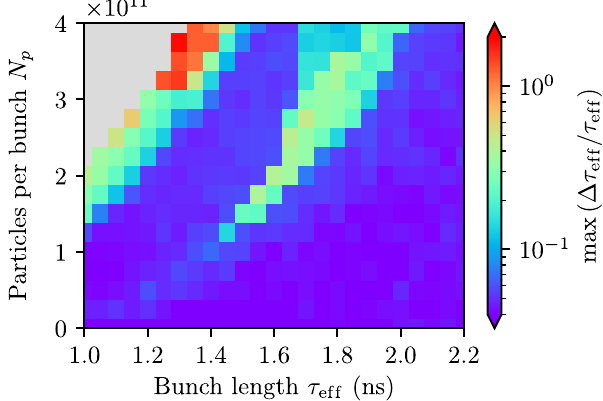
FIG. 2. Longitudinal stability map obtained from BL on D simulations for single-rf operation ( r ¼ 0 ) and with the pre- LS2 impedance model (Fig. 1). The color code indicates the maximum relative oscillation amplitude of the bunch length during 10 5 turns. The gray area indicates parameters for which the initial stationary distribution was not found. The SPS parameters are according to Table I.